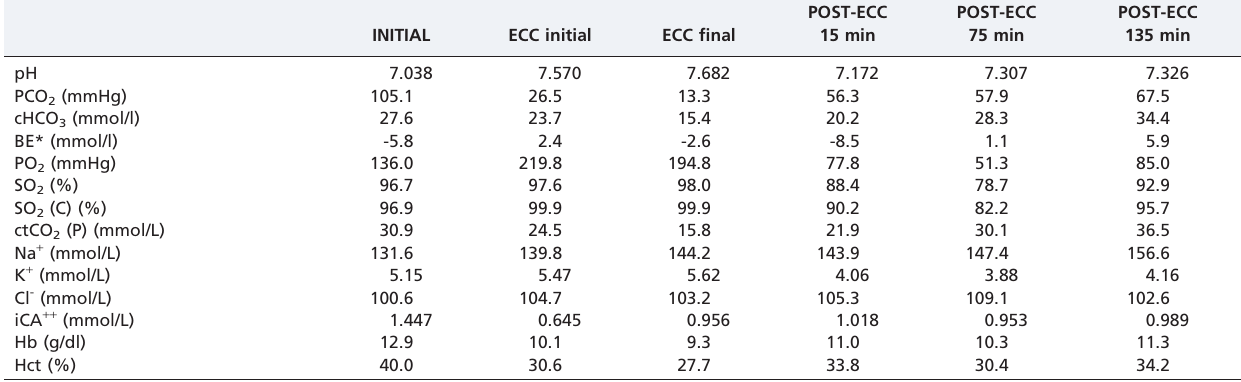
Table 1 - Blood gas levels, electrolyte concentrations, and hemoglobin and hematocrit levels throughout the modified Norwood